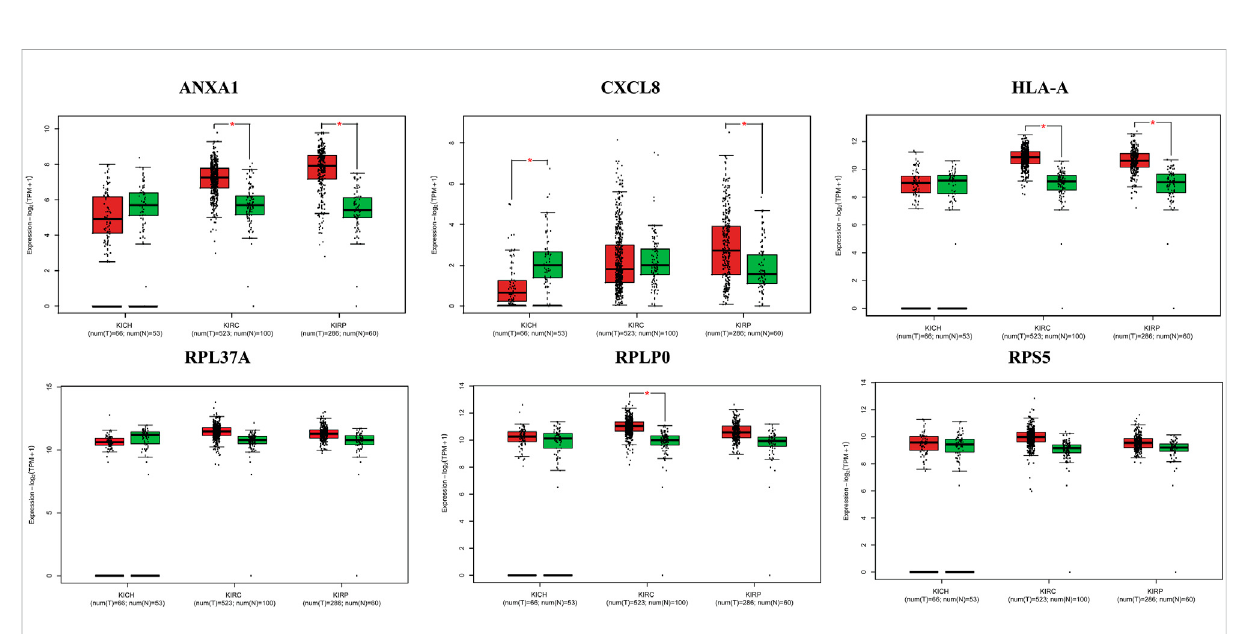
FIGURE 6 Box plots of selected hub genes ANXA1, CXCL8, HLA-A, RPL37A, RPLP0, and RPS5 in kidney cancer (KIRC, KIRP, and